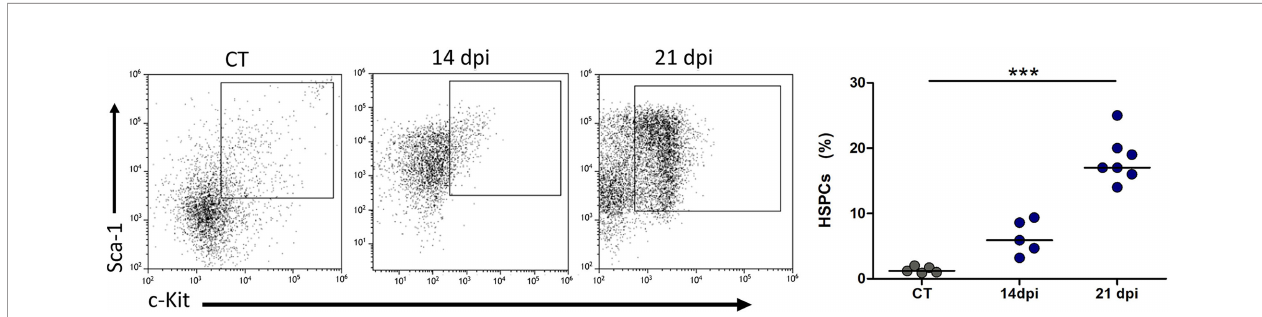
FIGURE 7 | Extramedullary hematopoiesis during oral Trypanosoma cruzi infection. Representative dot plots of Sca-1 versus c-kit expression gated in the Lin − compartment and relative number of HSPCs (Lin − Sca-1 + c-Kit + ) in the spleen. Bars indicate median; circle depicts individual mice in infected (14 and 21 dpi) and control (CT) groups. The data are representatives of 1 experiment with 5 – 7 animals per group. Statistical differences were ascertained with the non-parametric Kruskal – Wallis ANOVA test with Dunn ’ s multiple comparison test. *** p < 0.0001. US, stained